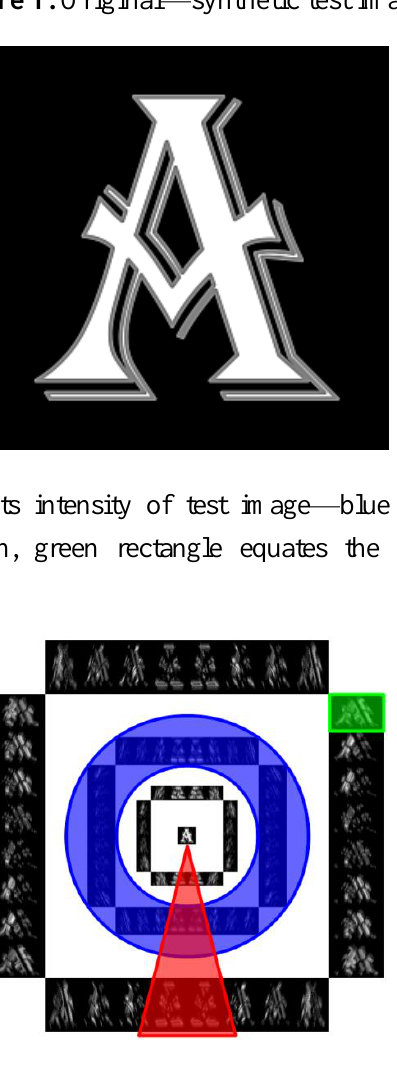
Figure 1. Original—synthetic test image.